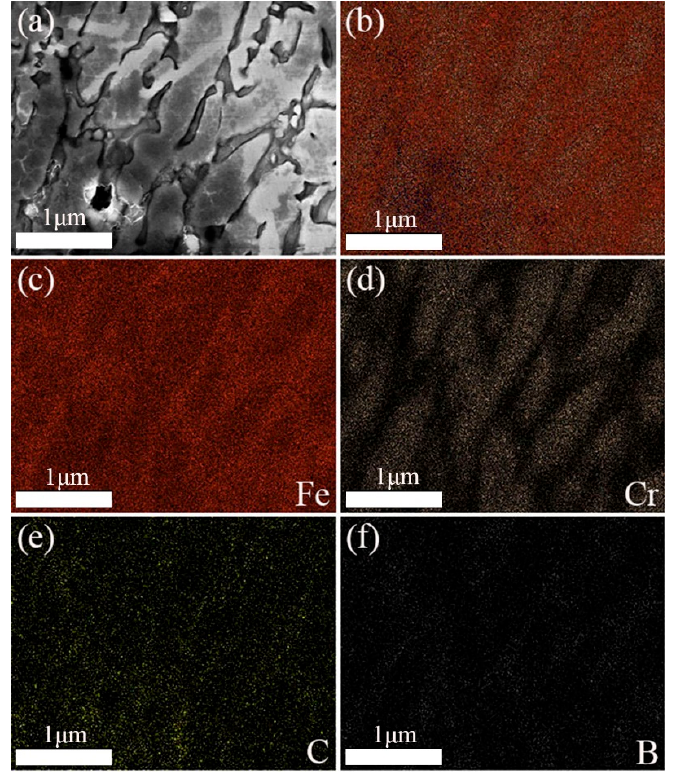
Figure 9. The elemental distributions of Coating 2: ( b ) the element distribution where all elements exist; ( c – f ) the element distribution of Fe, Cr, C, and B elements.